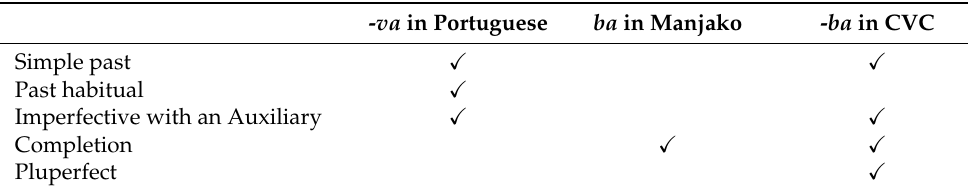
Table 2. The functions of - ba in CVC, - va in Portuguese, and ba in